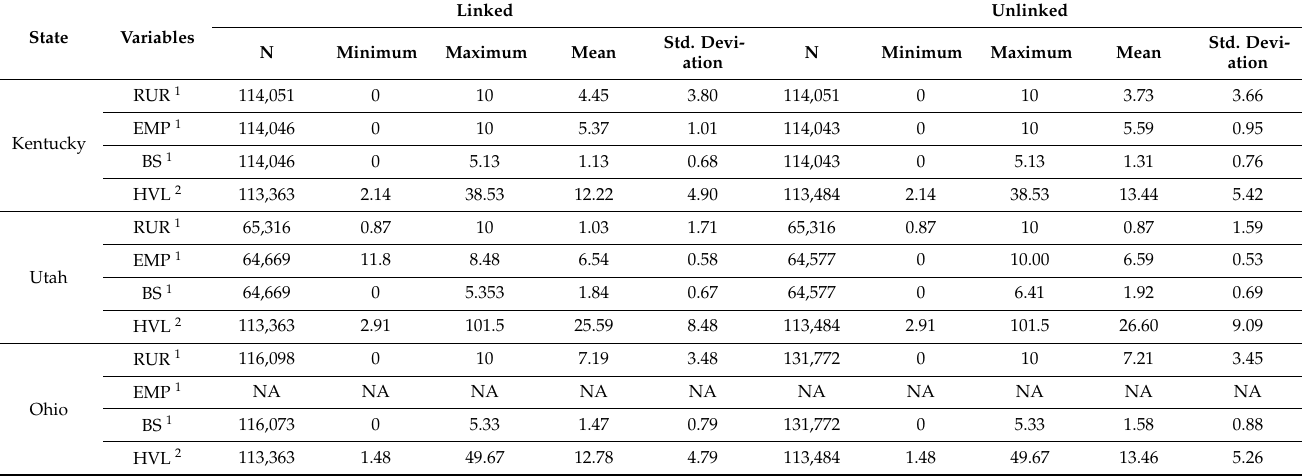
Table A3. Summary Statistics of Predictor Variables; Kentucky, Utah and